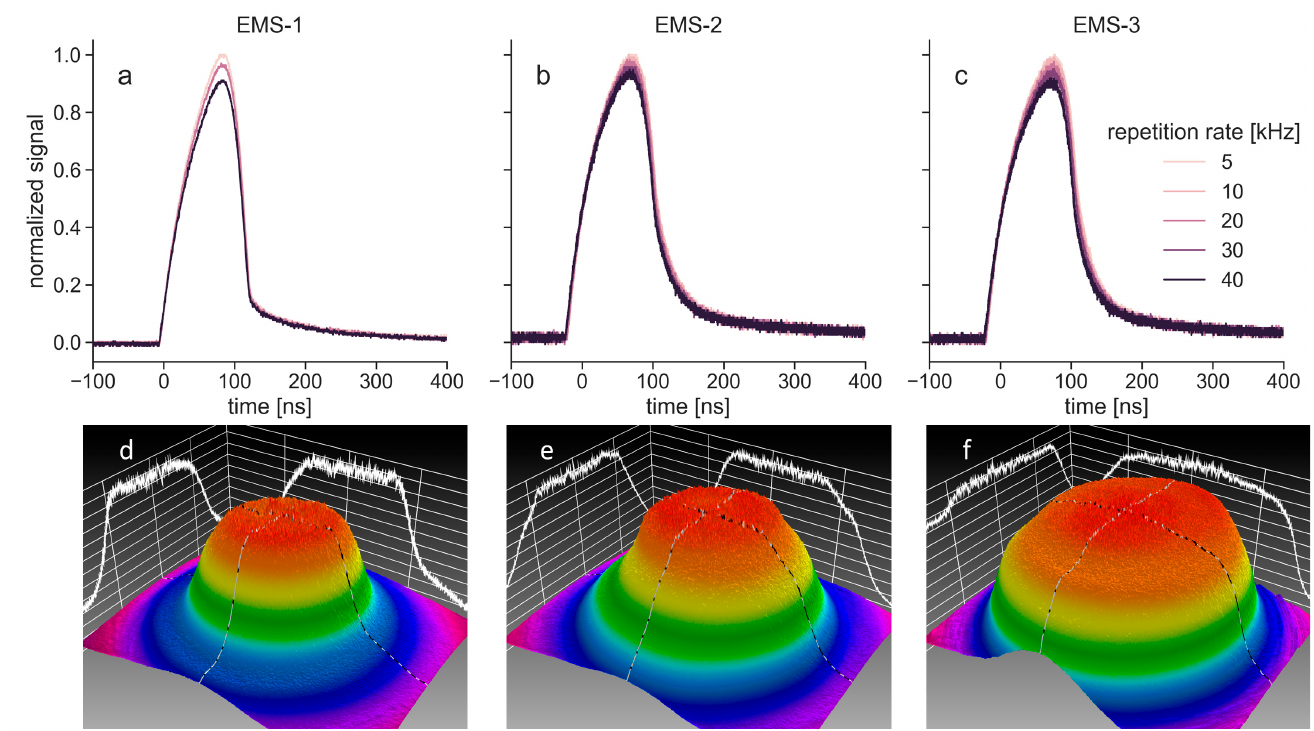
Figure 3. Temporal and spatial characteristics of the three EMS lasers (EMS-1, EMS-2 and EMS-3): ( a – c ) pulse recordings of each EMS laser recorded at different repetition rates. EMS-1 was measured at three repetition rates while EMS-2 and EMS-3 were also measured at 10 kHz and 30 kHz; ( d – f ) color-coded spatial intensity distributions of the three EMS lasers. Magenta represents the lowest light intensity, and red represents the highest light intensity. White lines that are projected onto the grid planes are intensity profiles along center lines in the x- and y-directions.